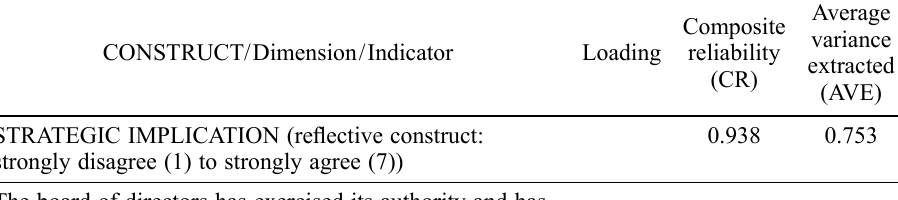
Table 1. Measurement model